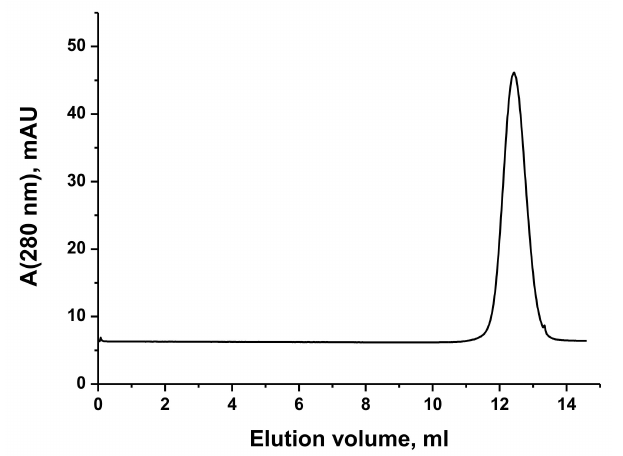
Figure 1. VP5454 gel filtration elution profile. Column size and specifications—a calibrated Superdex 200 column (Cytiva, Marlborough, MA, USA) bed volume of 24 mL equilibrated in 50 mM pyrophos- phate buffer pH 9.0 supplemented with 50 mM NaCl. The peak corresponds to a tetramer for the native enzyme. The column was calibrated using Gel Filtration calibration kit (Cytiva).